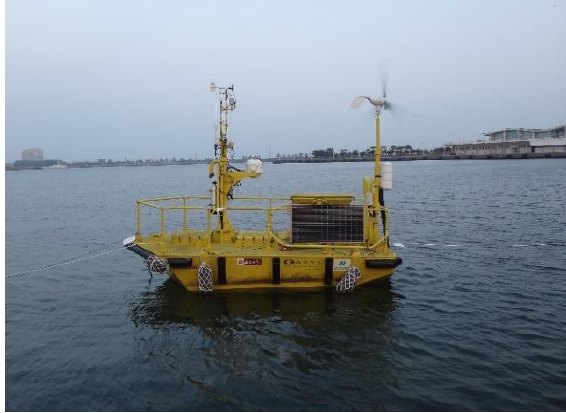
Figure 1. Lidar used in this